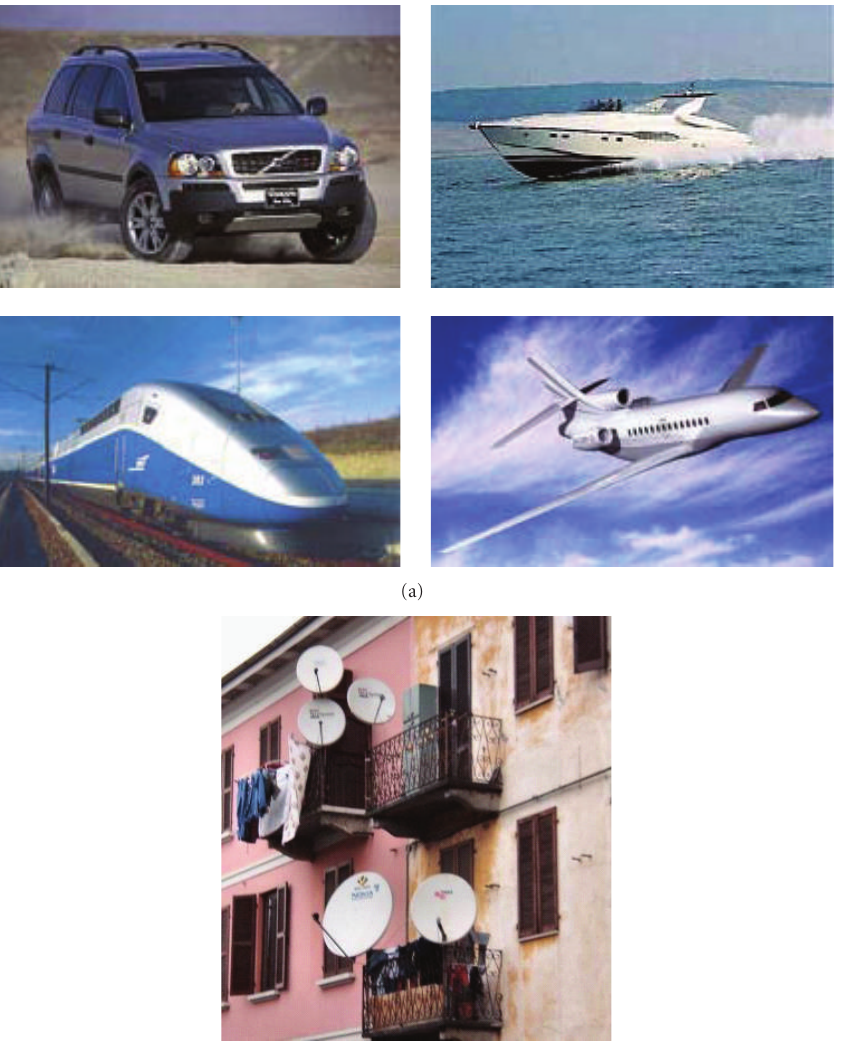
Figure 1: Typical scenarios of applications: (a) mobile vehicles such as cars, trains, boats, and trains; (b) example of strong environmental impact that could be reduced with the employment of flat wall-mounted antennas for DVB and radio